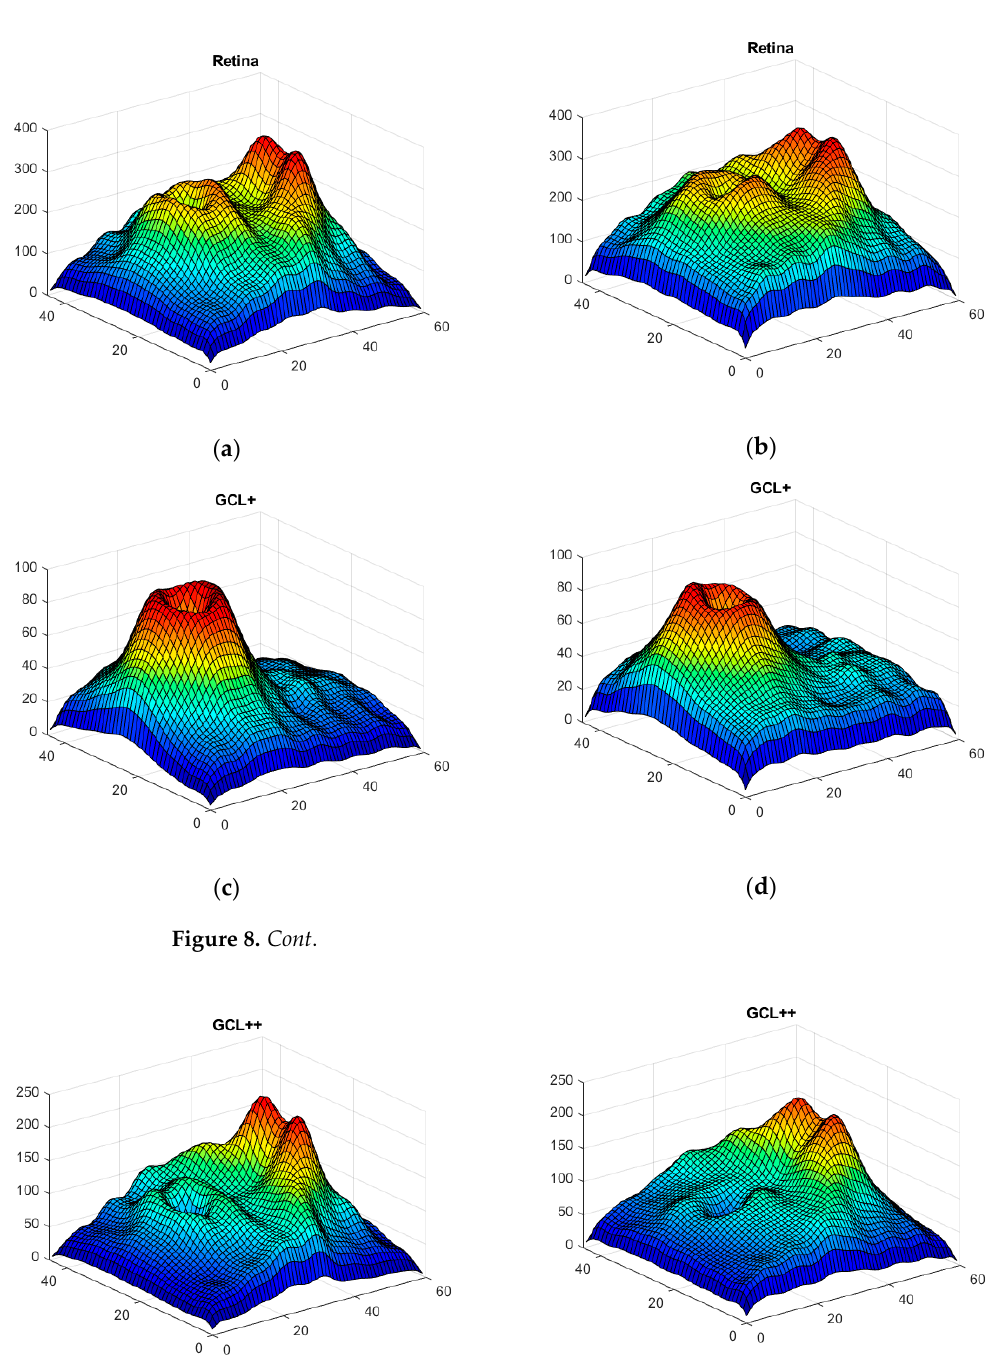
Figure 8. 3D images of the 3 structures synthesized with DCGAN; mean value in all control subjects (left) and mean value in MS patients (right). ( a , b ) Complete retina; ( c , d ) GCL+ layer; ( e , f ) GCL++ layer.